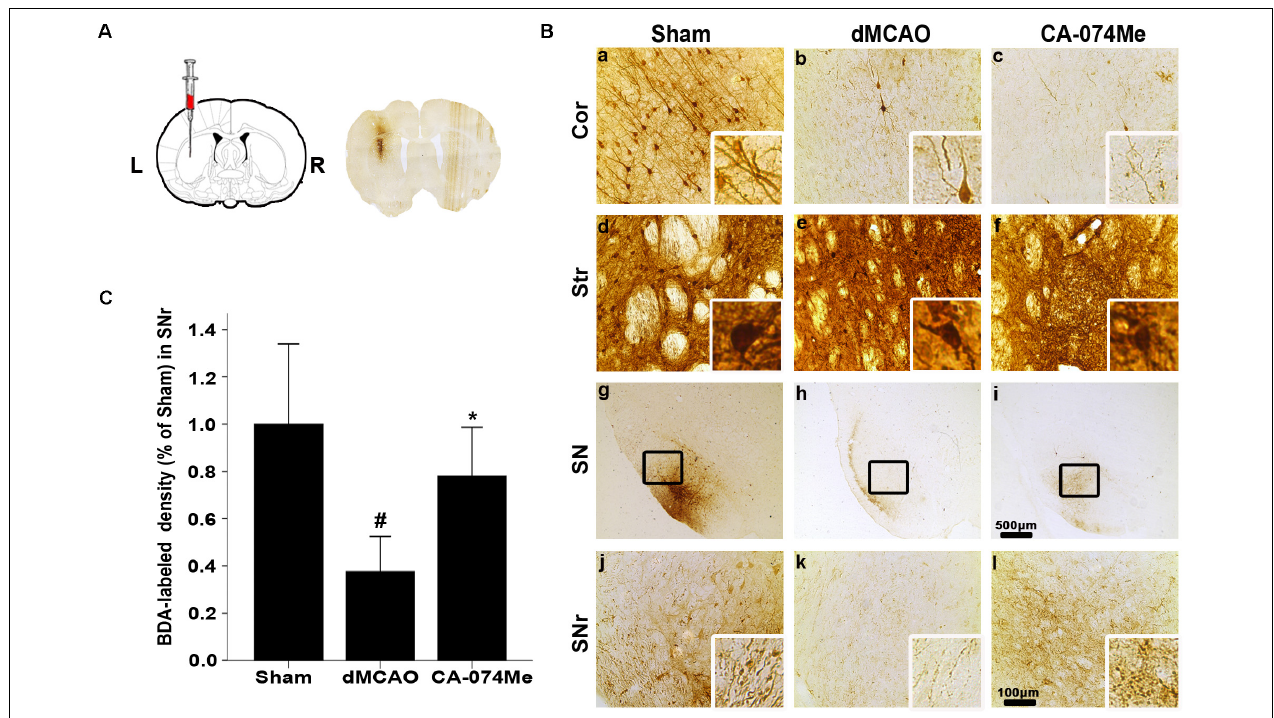
FIGURE 6 | Cortico-striatum-nigral tract tracing with BDA. (A) The representative image of injection site. (B) Representative microphotographs of histochemical photographs displayed BDA-labeled in the ipsilateral cortex, striatum, and SNr at sham-operated group ( n = 5) (a,d,g,j) , dMCAO group ( n = 5) (b,e,h,k) , and CA-074Me group ( n = 6) (c,f,i,l) . (C) Quantitative analysis of BDA-labeled density in the SNr after dMCAO. Data are expressed as percentage of value of sham-operated animals. Each bar represents the mean ± SD. ∗ p < 0.05 versus the dMCAO animals. # p < 0.05 versus the sham-operated group. Scale bar: a–f , j–l : 100 µ m; g–i : 500 µ m. Cor, cotrex; Str, striatum; SN, substantia nigra; SNr, substantia nigra pars reticulata; Sham;